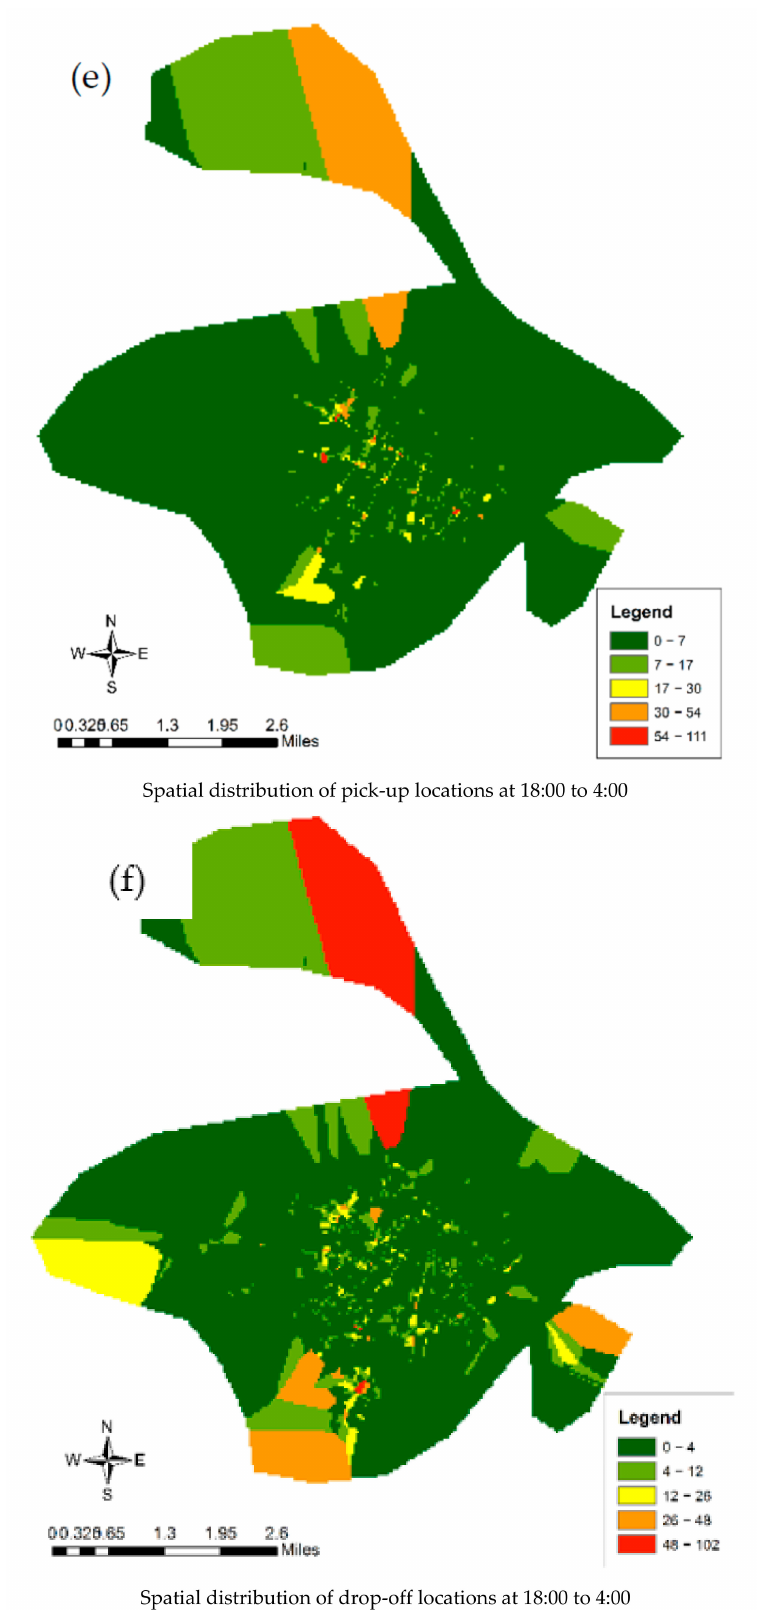
Figure 6. Spatiotemporal distribution of pick-up and drop-off